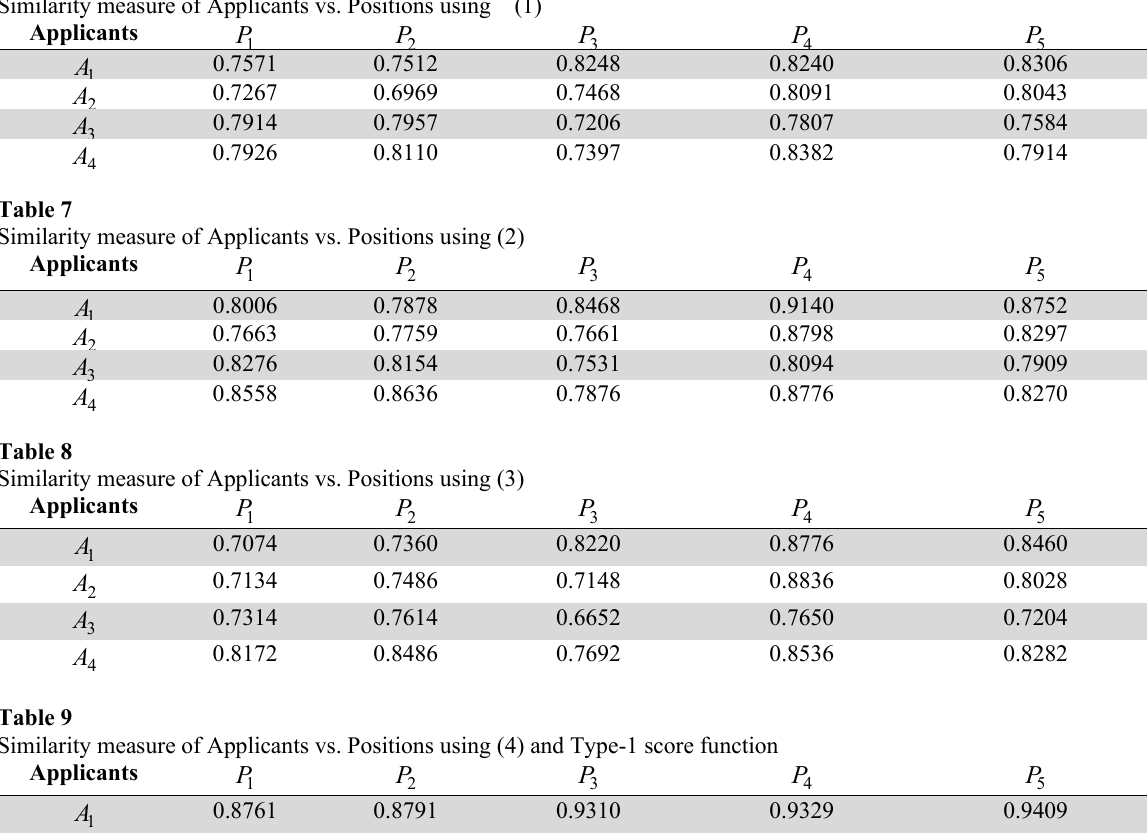
Similarity measure of Applicants vs. Positions using (1)